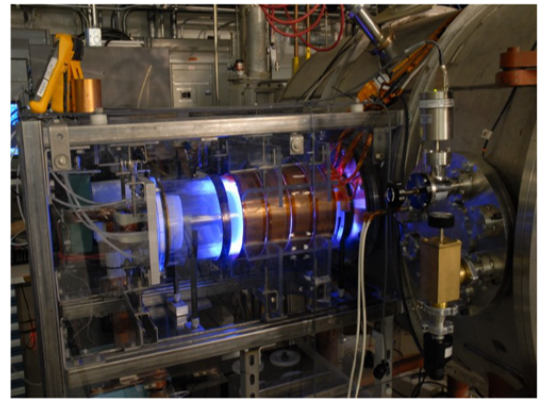
Figure 13. XOCOT-T3 experiment (from [54]; reproduced with permission of the author).